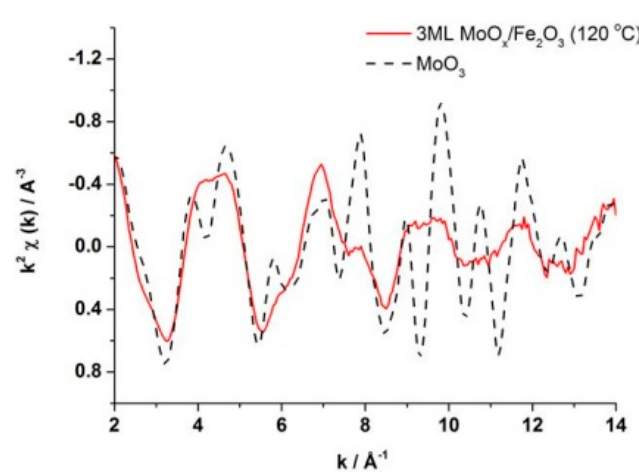
Figure 5. k2 ‐ weighted data and (6) Fourier transform (non phase ‐ corrected) for 3ML MoOx/Fe2O3 (120 °C) and MoO 3 . Image adapted from C. Brookes et al. ACS Catal. , 2014 , 4 (1), pp. 243–250 [16].